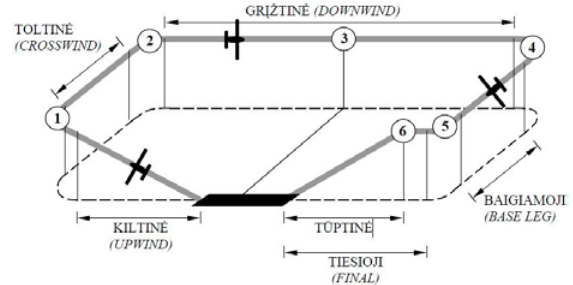
Fig. 1. Flight circuit structure (Žilienė